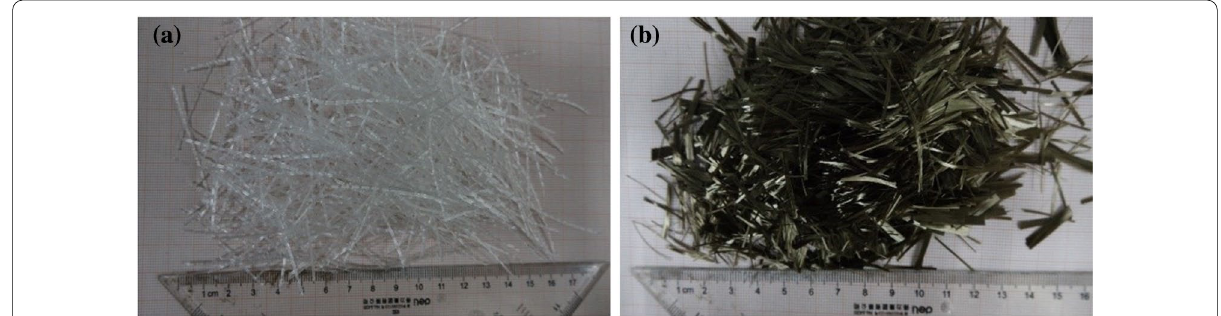
Fig. 1 External shapes of fibers: a CF; b